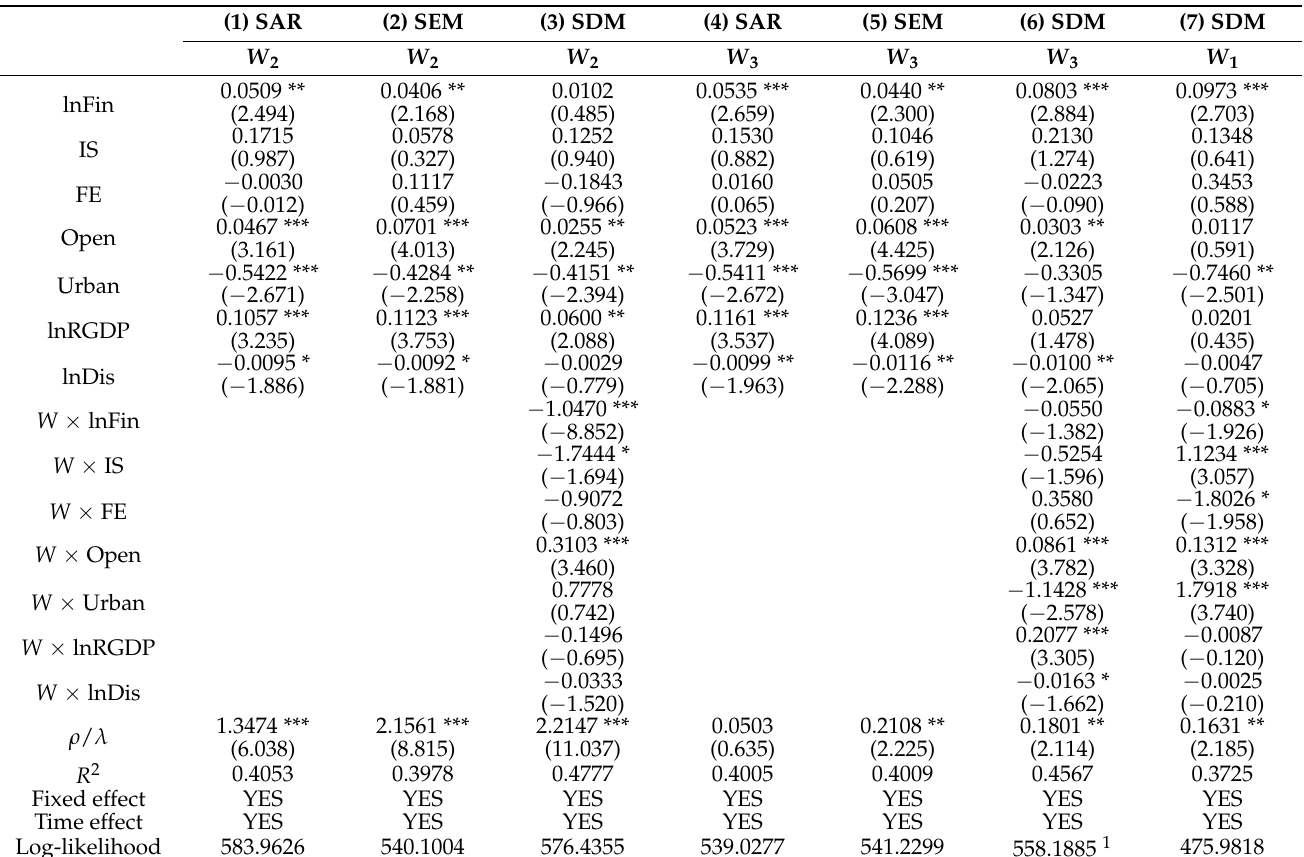
Table 10. The results of robustness